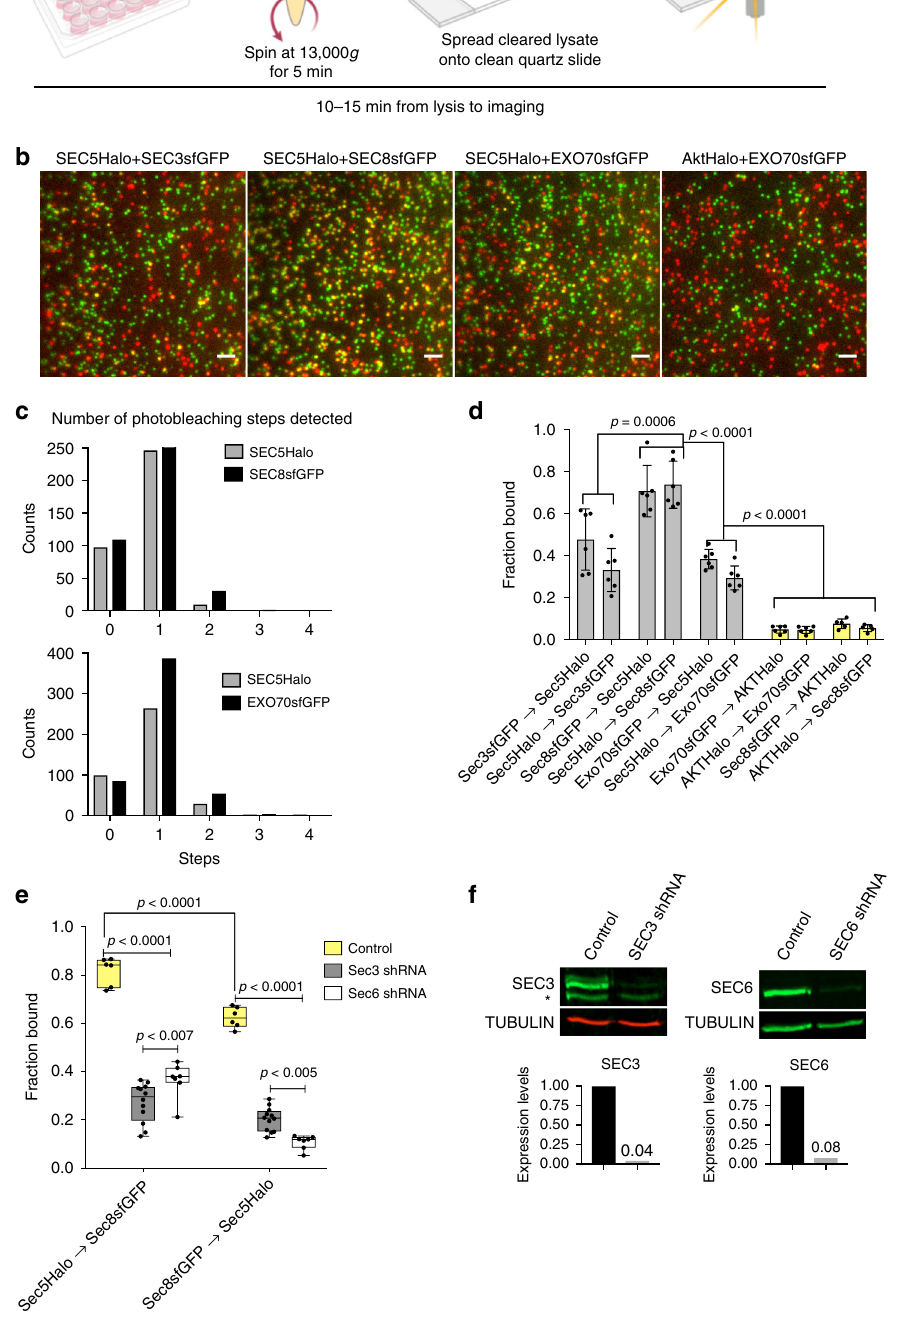
Fig. 5 Assessment of fractional binding using single-molecule approach. a Diagram showing experimental work fl ow. b Cleared cell lysates from the indicated double knock-in cells were spread between quartz slides and glass coverslips for TIRF imaging. The GFP and Halo + JF585 fl uorophores were excited simultaneously with 488-nm and 561-nm lasers at 12.5 Hz for 40 s. Scale bar = 1 µ m. c Number of photobleaching steps detected for SEC5-Halo and SEC8-GFP in experiments shown in panel b . d Quanti fi cation of the fraction of subunit A bound to ( – > ) subunit B from experiments shown in panel b . Numbers of particles analyzed for each pair are shown in Supplementary Fig. 4c. e Fraction of SEC5-Halo and SEC8-GFP bound to each other in SEC3 or SEC6 shRNA-treated cells compared to control. Center line denotes mean. f Western blot analysis of SEC3 and SEC6 shRNA knockdown ef fi ciencies in the experiment shown in e . Error bars denote ± SD. Statistical signi fi cance was computed by one-way ( d ) or two-way ( e ) ANOVA, followed by Tukey ’ s multiple comparison tests. Experiments were repeated three times and data were